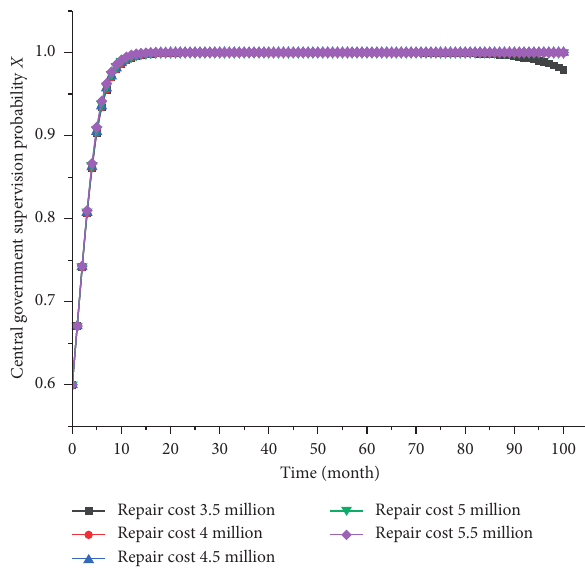
Figure 3: The impact of repair costs on central government strategy choices.